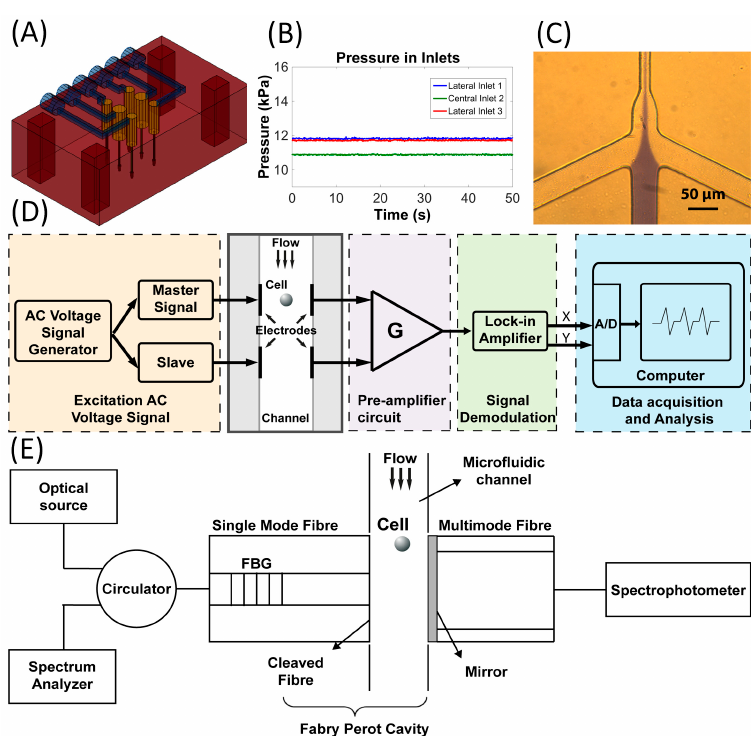
Figure 1. Characteristics of the developed microfluidic platform: ( A ) three-dimensional scheme of the poly(methyl methacrylate) (PMMA) acrylic chip holder; ( B ) the pressure in each inlet measured by the pressure monitoring system in an experimental assay; ( C ) hydrodynamic focusing situation in the central channel obtained using the previously-measured values; ( D ) schematic diagram of the complete microfluidic single cell impedance analysis system; and ( E ) scheme of the setup for the simultaneous measurement of the refractive index, absorption and fluorescence in the microfluidic chip.